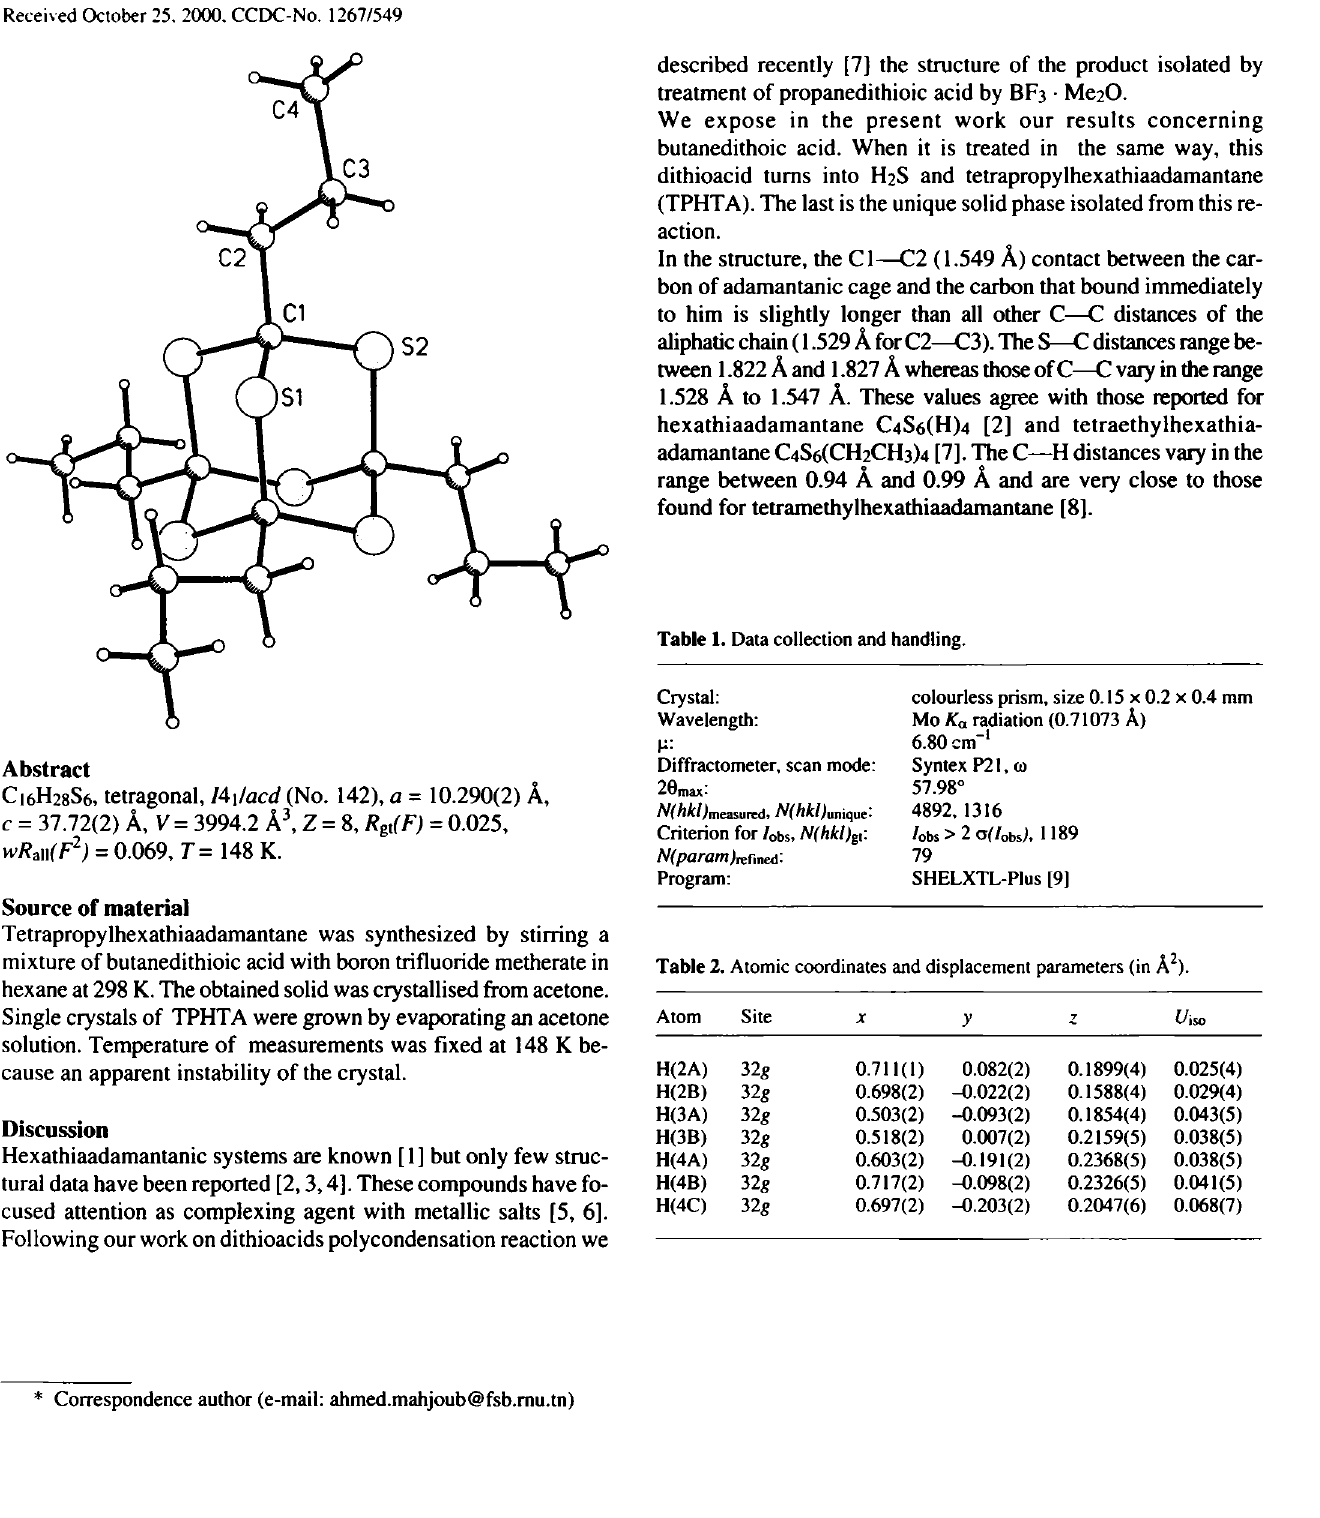
Table 2. Atomic coordinates and displacement parameters (in A 2